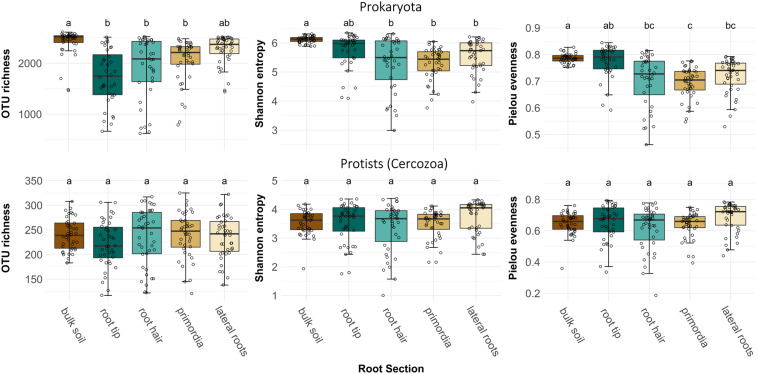
Operational taxonomic unit richness, alpha diversity (Shannon index) and evenness (Pielou’s index) of prokaryote and protist (cercozoan) communities in bulk soil and at four different root regions of maize plants. Different letters indicate differences between means (Welch’s one-way with Games-Howell post hoc test). Prokaryote OTU richness: F4,186 = 14.12, p < 0.001, prokaryote Shannon diversity: F4,186 = 12.88, p < 0.001, prokaryote Pielou’s evenness: F4,186 = 16.71, p < 0.001, protist OTU richness: F4,193 = 1.09, p > 0.05, protist Shannon diversity: F4,193 = 1.99, p > 0.05, and protist Pielou’s evenness: F4,193 = 2.62, p = 0.36.